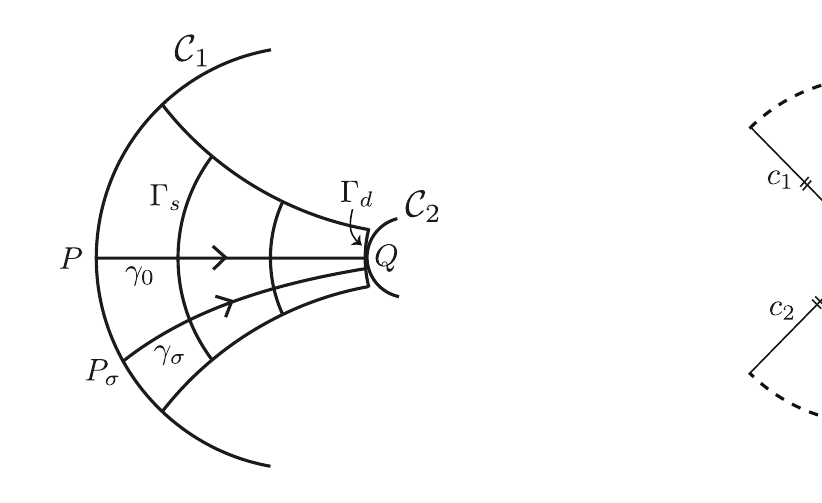
Figure 2 . Left inset: boundary components C 1 and C 2 of extrinsic curvatures k 1 and k 2 joined by a distance-minimizing geodesic γ 0 . If k 1 > 1 , the curves Γ s , defined in the main text, have increasing extrinsic curvatures. The position of Γ d with respect to C 2 then implies that k 2 < − k 1 . Right inset: conical singularities of angles less than 2 π never attract distance minimizing geodesics like γ 0 on the left inset. If they were, their length could be reduced by smoothing the corner as indicated (thick curve). This always works because the geodesics c 1 and c 2 (thin lines) are identified to form the cone and one of the angles ˆ a or ˆ a 0 is then always less than π